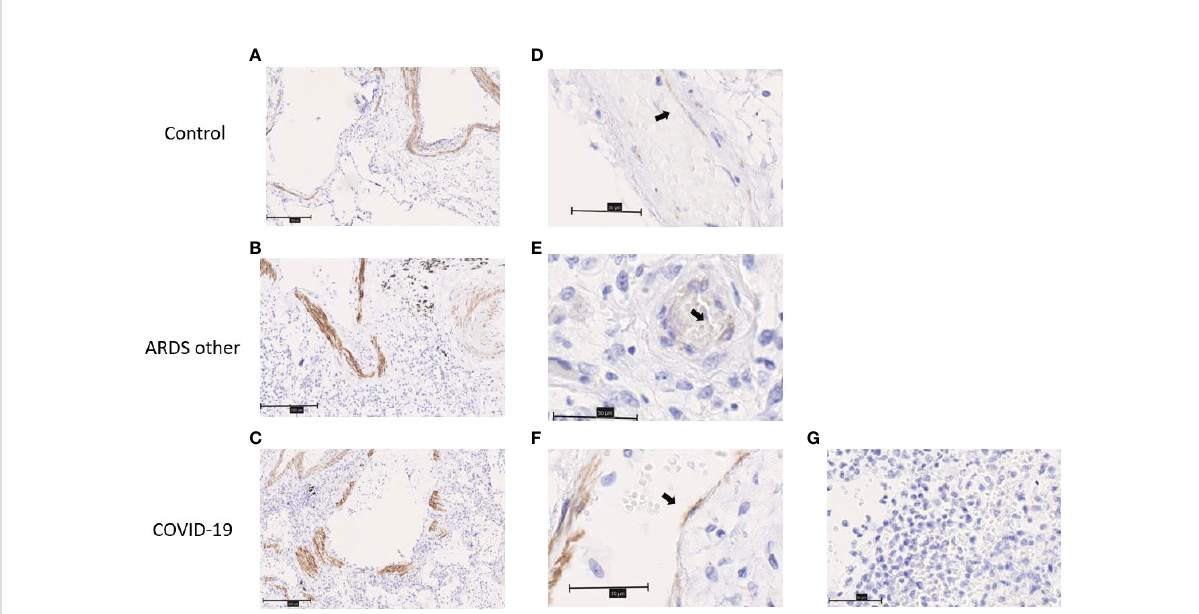
FIGURE 4 Immunohistochemistry staining of ChemR23 on lung slides from autopsied COVID-19 patients and controls (autopsied patient without major pulmonary lesion (control) and patient with ARDS from another origin (ARDS other)). (A – C) . Representative staining of smooth muscle cells from arteries and bronchia. Field magni fi cation 100x. Scale bar: 100µm. (D – F) . Representative staining of endothelial cells (black arrows). Field magni fi cation 400x. Scale bar: 50µm. (G) . Representative image from area of acute pneumonia in COVID-19 patients, without ChemR23 staining. Field magni fi cation 400x. Scale bar: